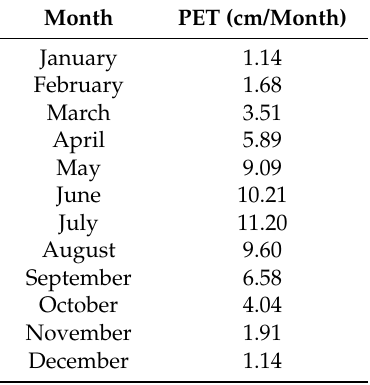
Table 1. Average monthly potential evapotranspiration (PET)